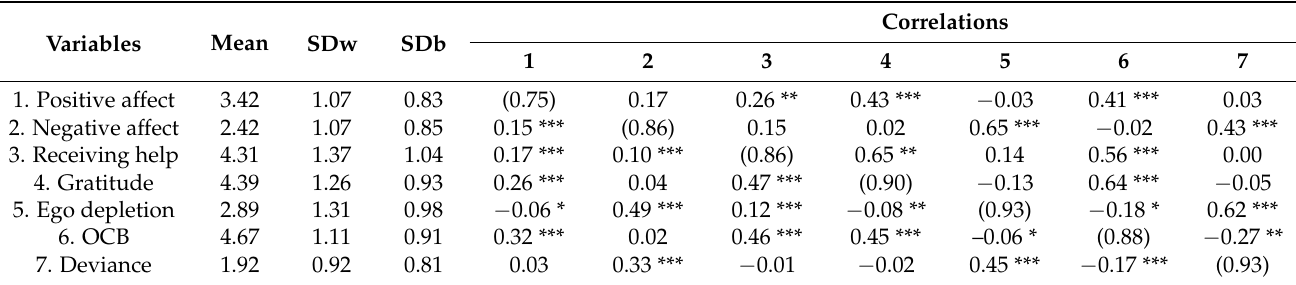
Table 1. Descriptive statistics and correlations among study